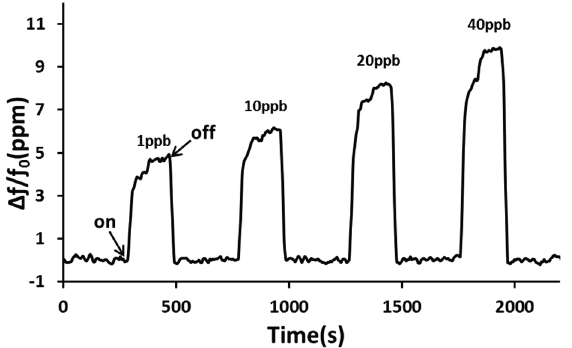
Figure 5. The transient response of a sensor to NO at various concentrations using dry nitrogen as carrier gas at room